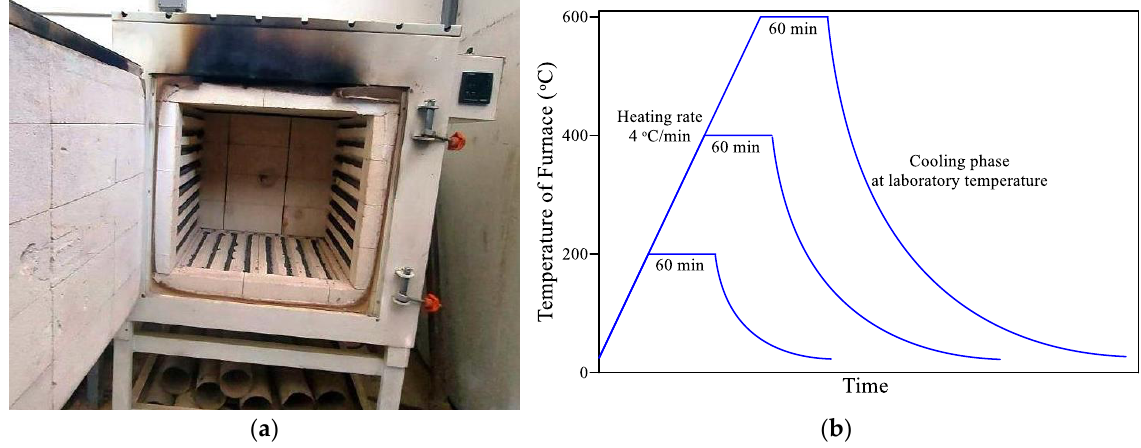
Figure 1. Heating of test specimens; ( a ) the electrical furnace; ( b ) the heating regime curve.